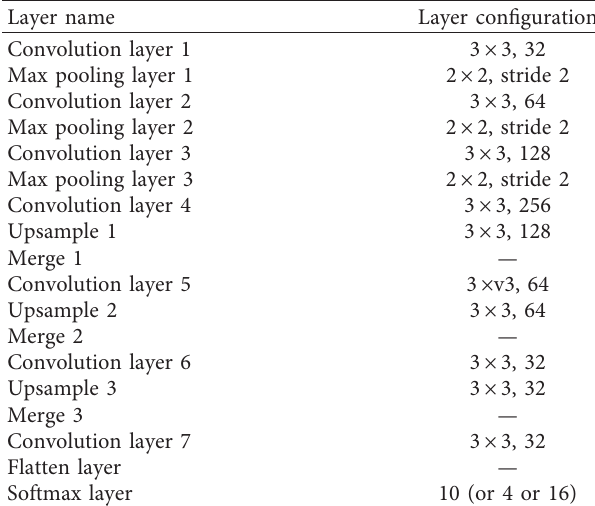
Table 4: Configuration of the